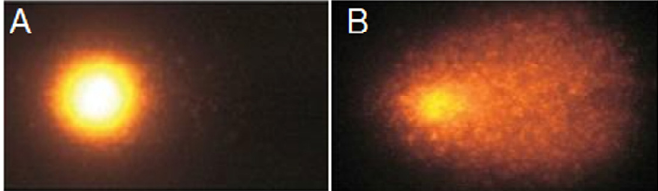
FIGURE 1 – Oxidative DNA damage ( TM) by alkaline electrophoresis of a single cell (comet assay). A. Cell without oxidative DNA damage; B. Cell with severe oxidative DNA